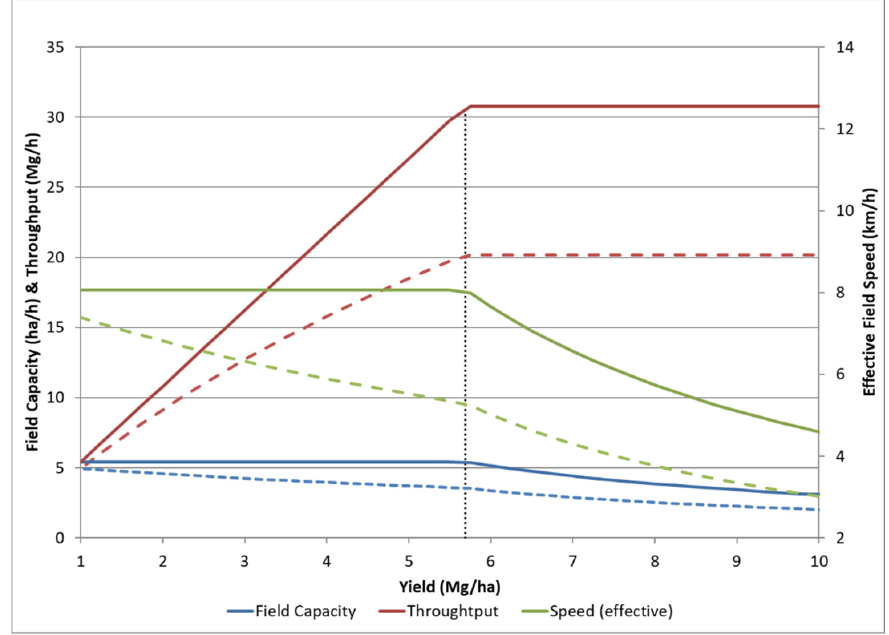
Figure 3. Impact of bale wrap/eject time on achieved field capacity, speed, and achieved throughput. Using Equations (1), (2), (4), and (6) and assuming operating conditions of: W = 6.7 m, v = 10.9 km/h, E f = 0.74, C mx = 30.8 Mg/h, Y c = 5.6 Mg/ha, B m = 0.52 Mg, and t w = 32 s.